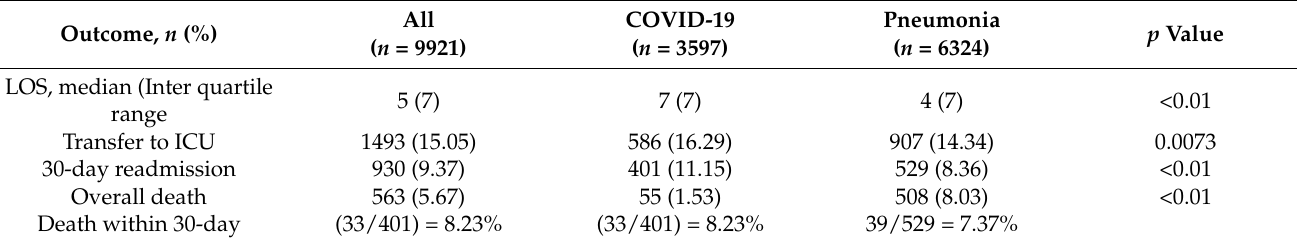
Table 2. Outcomes of patients discharged from the hospital with COVID-19 or pneumonia, NGHA, Saudi